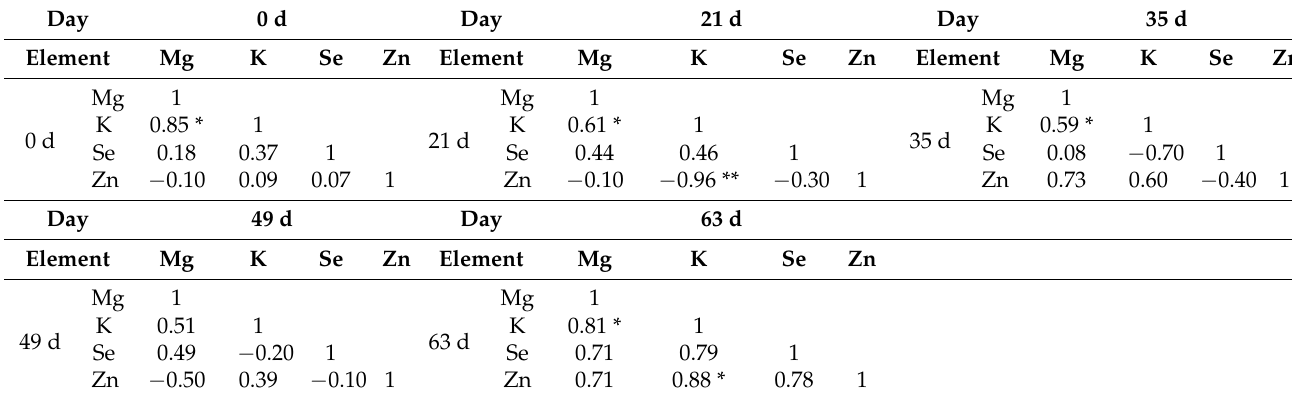
Table 7. Correlation between the depositions of mineral elements in the